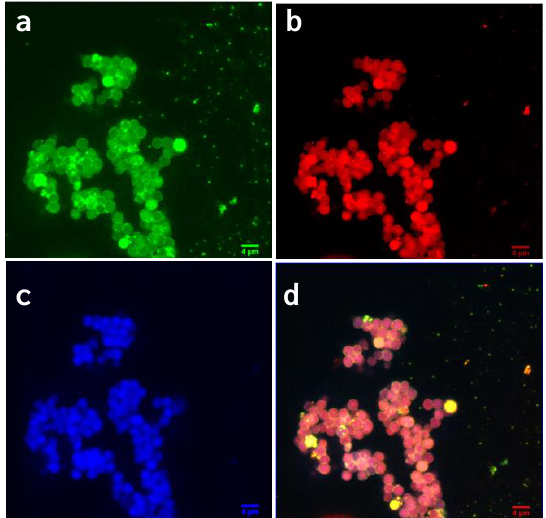
Figure 7. Confocal microscopy images of SiO 2 (calcein)@P2VP- b -PEO@TA@PS 10 -PEO 10 (NileRed)@TA@P2VP- b -PEO@TA@PS 10 -PEO 10 (pyrene) particles. In images ( a – c ), the green channel from calcein (excitation 495 nm/emission 519 nm), the red channel from Nile Red (excitation 550 nm/emission 573 nm), and the blue channel from pyrene (excitation 359 nm/emission 457 nm) are shown, respectively. Image ( d ) is the merged channel from the green, red, and blue channels of calcein, Nile Red, and pyrene, respectively.